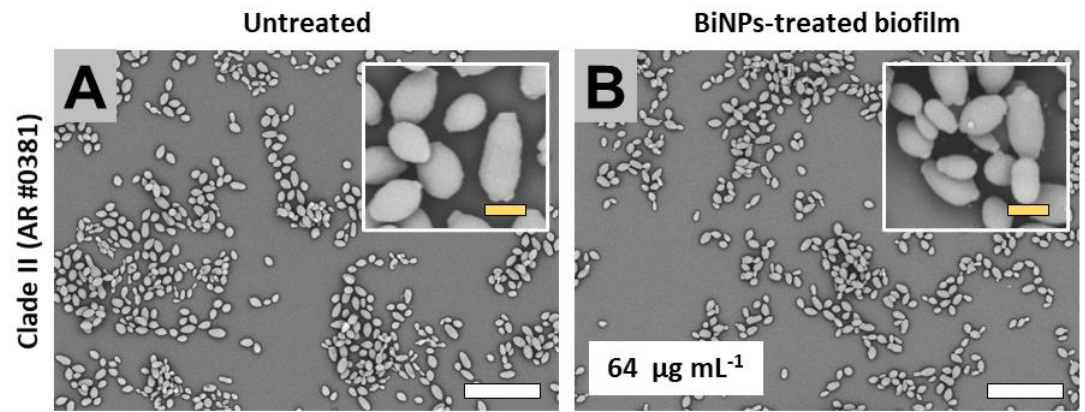
Figure 4. SEM observations on the BiNP antibiofilm activity on the C. auris strains from the Clade II. The subinhibitory concentrations of the BiNPs mildly reduced the biofilm formation ( B ) when compared with the control ( A ) on the C. auris strains no. 0381. The cell morphology remained mostly unaltered by the BiNP treatment ( A,B ). Scale bar: yellow 2 µm, white = 20 µm.